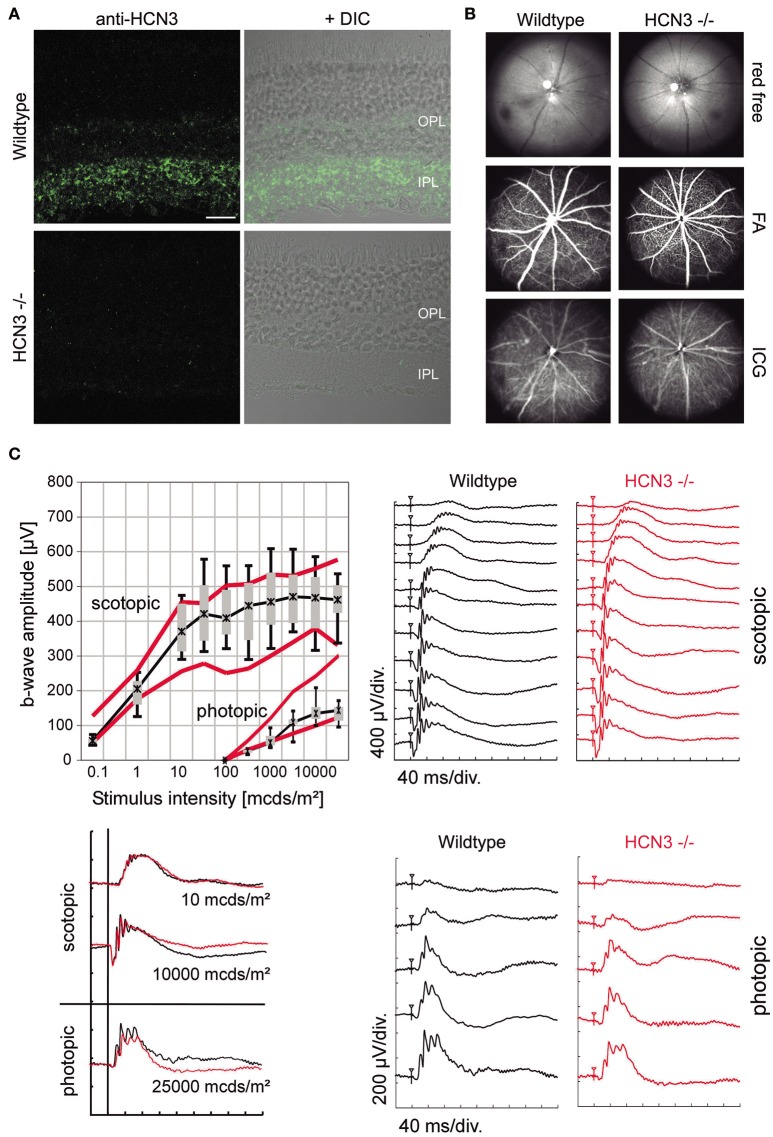
Characterization of retinal structure and function in HCN3−/− mice. (A) Expression of HCN3 in the retina. Wild type mice express HCN3 (green) in the inner plexiform layer (IPL) and the outer plexiform layer (OPL). The immunolabeling is absent in HCN3−/− mice. For visualization of the retinal layers, confocal fluorescent images are overlaid with DIC images of the same area. Scale bar, 20 μm. (B,C) Examination of retinal structure and function in vivo [wild type control mice (n = 5) and HCN3−/− (n = 5), age 3 months]. (B) Retinal imaging and angiography. Mice were examined with native SLO (red-free, 514 nm), fluorescein angiography (488 nm, barrier filter at 500 nm), and indocyanine green (ICG) angiography (795 nm, barrier filter at 800 nm). HCN3−/− mice show no signs of neuroretinal or vascular alterations. (C) Retinal function assessment via ERG. Top right, Representative scotopic ERG intensity series (dark-adapted conditions). Bottom right, Representative photopic ERG intensity series (light-adapted conditions). Top left, Quantitative scotopic and photopic b-wave amplitude data from HCN3−/− mice (box plot). Boxes: 25–75% quartile range, whiskers: 5 and 95% quantiles, asterisks: median. As a control, red bolded lines indicate the 25 and 75% quartile of the wild type group. bottom left, Overlay of representative ERG recordings under scotopic (0.01 and 10 cd*s/m2) and photopic (25 cd*s/m2) conditions. Wild type black traces, HCN3−/− red traces.